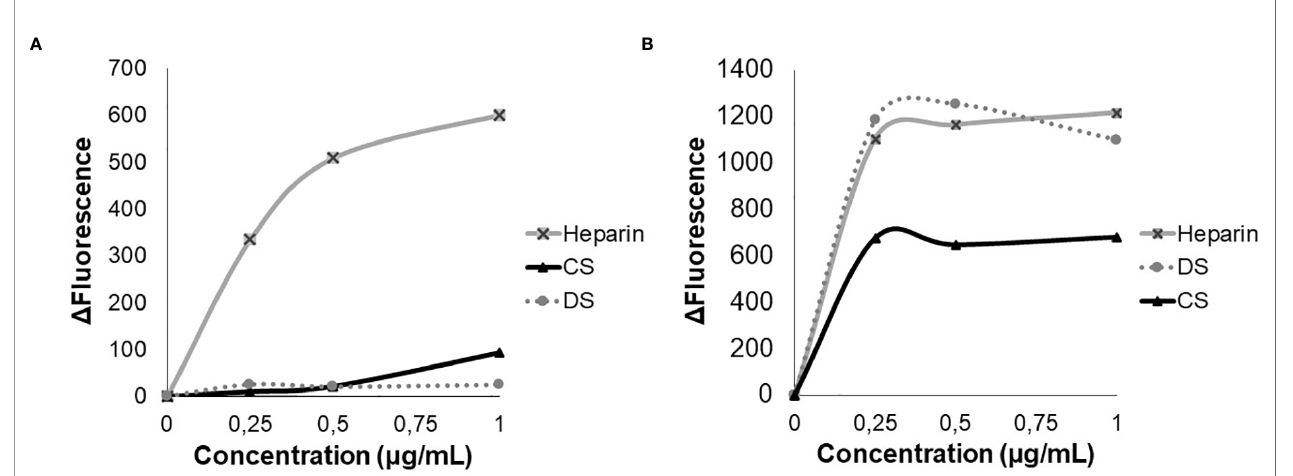
FIGURE 1 | Analysis of tryptophan emission. Heparin, dermatan sulfate (DS) and chondroitin sulfate (CS), were titrated in the presence of 3 µM of HS-binding peptide (A) or in the presence of 3 µM of scrambled peptide (B) . Excitation 280 nm, emission 350 nm. The HS- binding peptide interacts only with